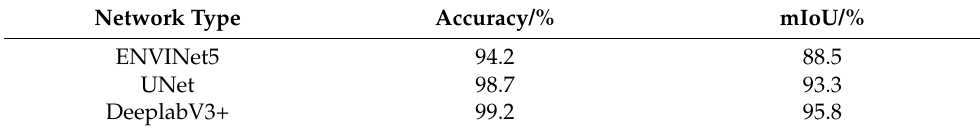
Table 4. Comparative test of different network structures in greenhouse area